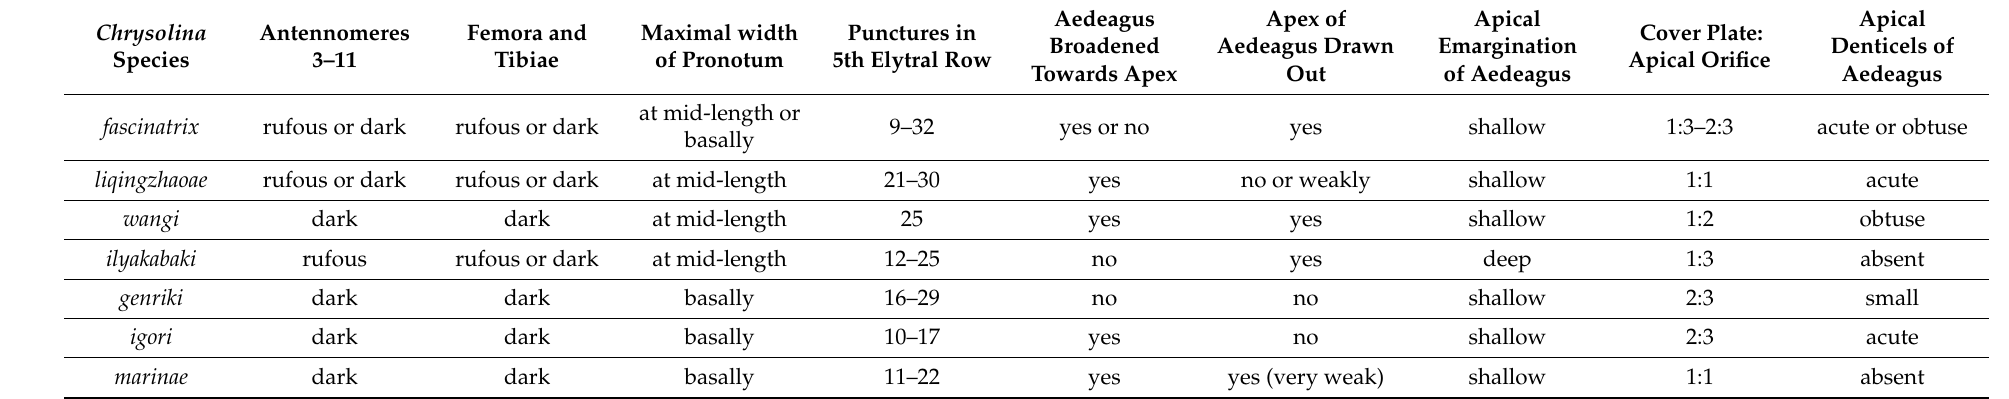
Table 1. Diagnostic characters of the